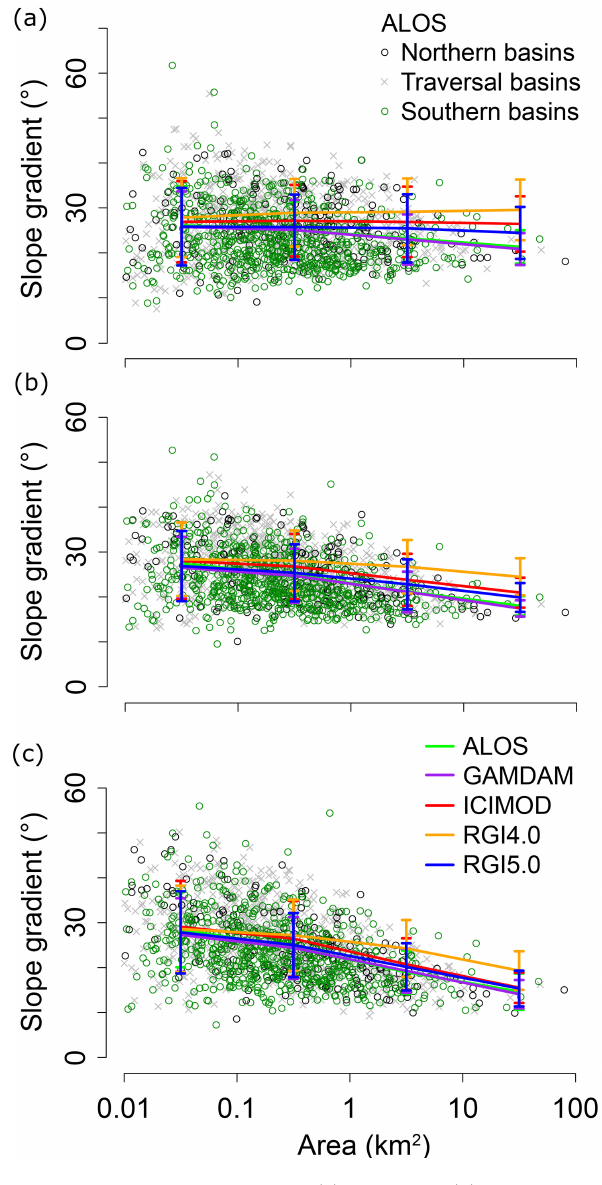
Figure 12. Slope gradients of the (a) upper half, (b) entire surface, and (c) lower half of ALOS-derived glacier outlines, categorised as northern/southern/traversal basins as shown in Fig. 1. Calculated mean values and standard deviations for four size classes are shown along with those of other inventories.